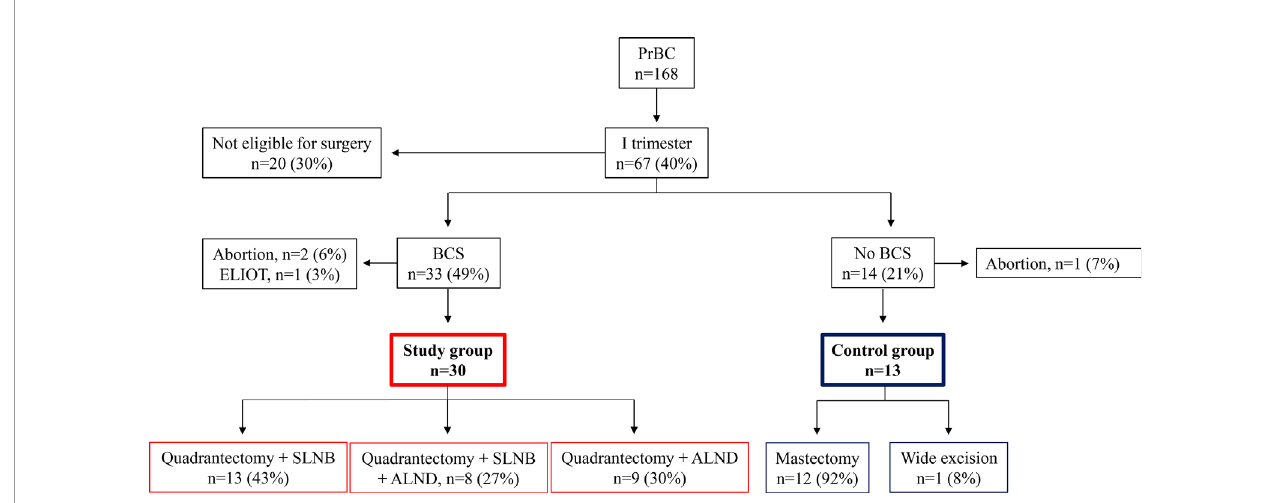
FIGURE 1 | Study fl owchart. PrBC, breast cancer during pregnancy. BCS, breast-conserving surgery; ELIOT, electron intraoperative radiotherapy; SLNB, sentinel lymph node biopsy; ALND, axillary lymph node dissection.